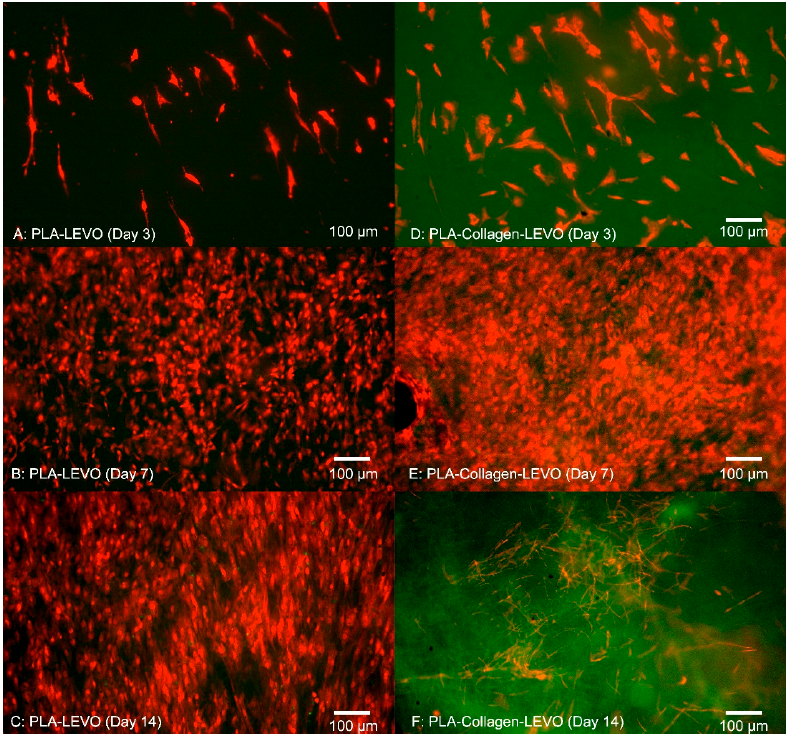
Figure 5. Fluorescent images of cell proliferation of RAOSMCs ( A ) PLA–LEVO after 3 days ( B ) PLA–LEVO after 7 days ( C ) PLA–LEVO after 14 days ( D ) PLA–collagen–LEVO after 3 days ( E ) PLA–